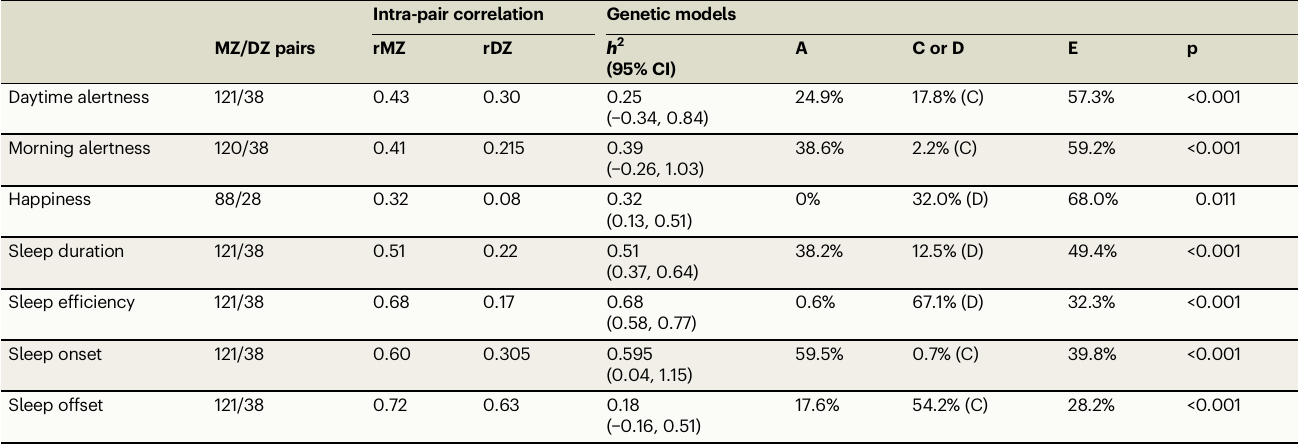
Table 3 | The heritability of alertness and sleep Intra-pair correlation Genetic